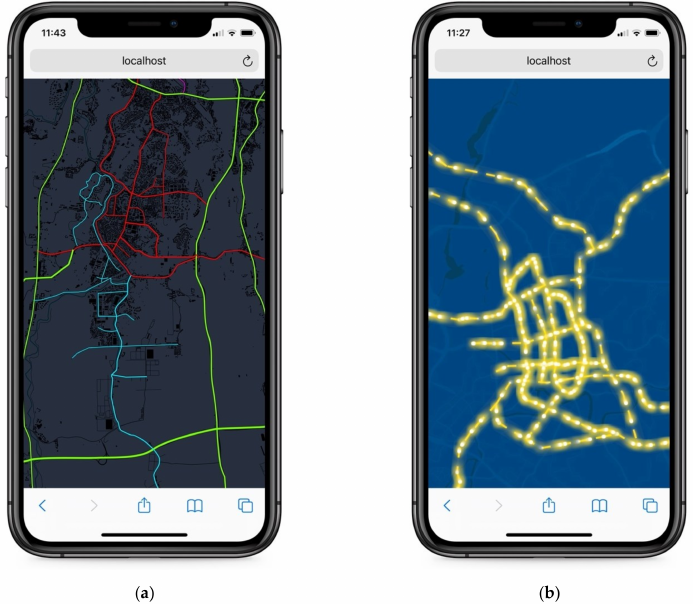
Figure 13. The interfaces for visualization maps. ( a ) Interface for the shape of roads with high occupancy. ( b ) Interface for 15 hot lines in urban areas with high vehicle